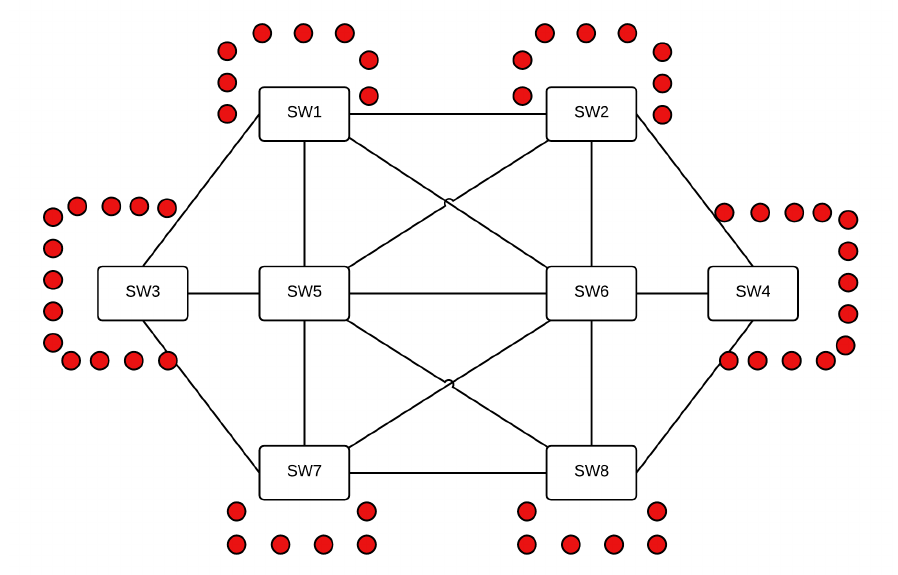
Figure 15. A representative A380 AFDX